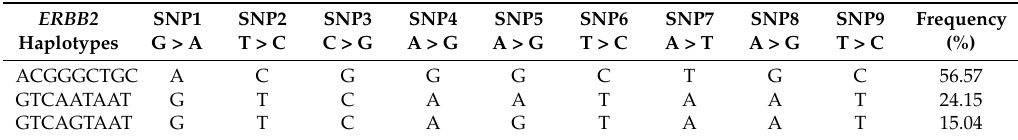
Table 5. Haplotype associations of the nine SNPs in ERBB2 with milk production traits in Chinese Holstein cattle (LSM ± SE).